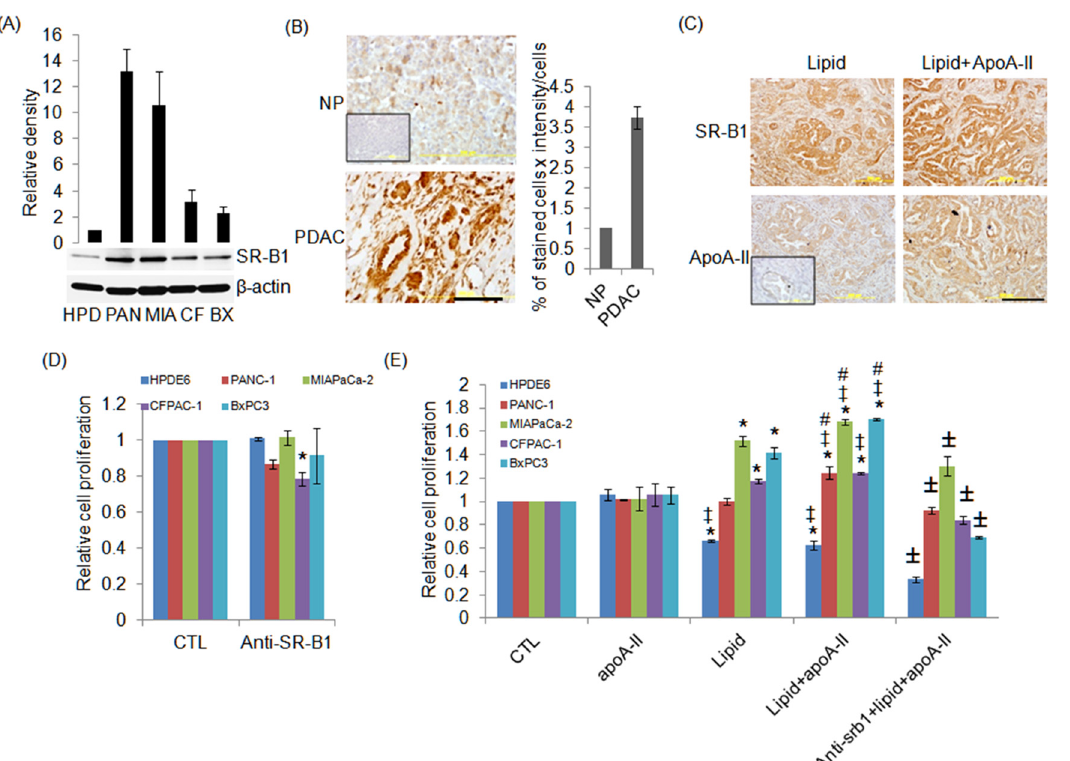
Fig 4. ApoA-II plus lipid increased lipid uptake and cell growth may be via SR-B1 in pancreatic cancer. (A) HPDE6, PANC-1, MIAPaCa-2, CFPAC-1 and BxPC3 cells were cultured and SR-B1 expression was measured by western blotting. The band intensity of the proteins was normalized with β -actin and HPDE6 was defined as 1. Values are the mean of two separate experiments. (B) Expression of SR-B1 by IHC on normal pancreas (NP) and human PDAC tissues. Inset, IgG represents the isotyped matched primary antibody to anti SR-B1. Graph shows the quantification of SR-B1 expression by the percentage of stained cells X intensity from 3 separate patients and NP was defined as 1. (C) Expression of SR-B1 and ApoA-II by IHC in corresponding xenografted PDAC tumours at 48 h after tail vein injection of lipid with or without ApoA-II. Inset, IgG represents the isotyped matched primary antibody to anti-ApoA-II. (D) Effects of anti SR-B1 alone in HPDE6, PANC-1, MIAPaCa-2, CFPAC-1 and BxPC3 cell growth. (E) Cells were pretreated with or without the SR-B1 antibody (2.5 μ g/mL) for 2 hours and then treated with ApoA-II, lipid and lipid plus ApoA-II for 48 hours. Proliferation was measured by crystal violet assay. Values are mean ± SD; n = 4. * , ‡ , # and ± p < 0.05 vs. control, ApoA-II, lipid and lipid+ApoA-II respectively, with the use of analysis of